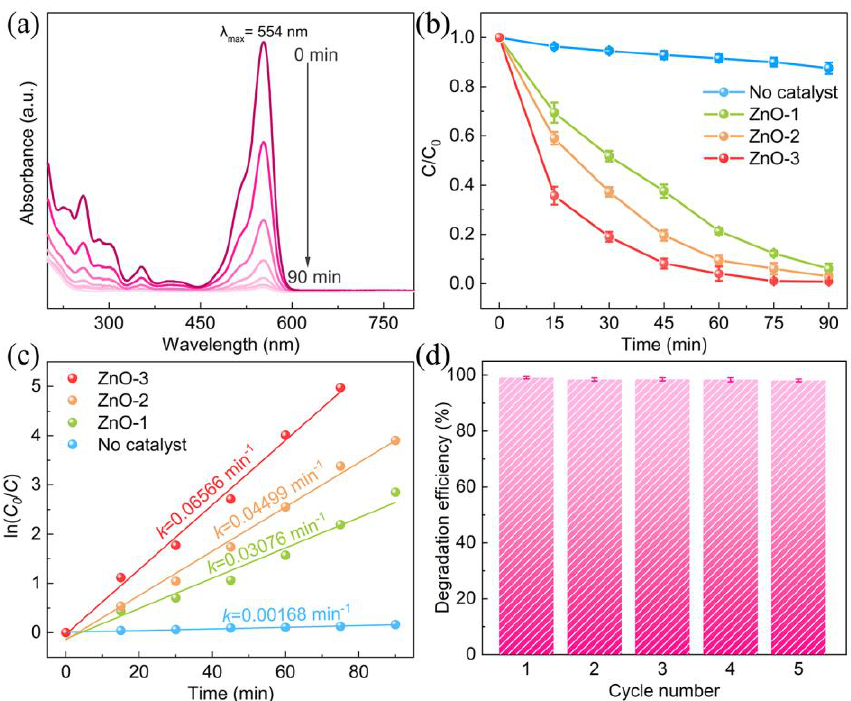
Figure 2. The catalytic properties of ZnO nanoparticles. ( a ) UV-Vis adsorption spectra of RhB (5 mg L −1 ) solution mediated by ZnO-3 under magnetic stirring with homemade PTFE disk for 90 min; ( b ) degradation efficiencies of RhB under magnetic by using a series of ZnO nanoparticles; ( c ) kinetic curves; ( d ) cycling stability.